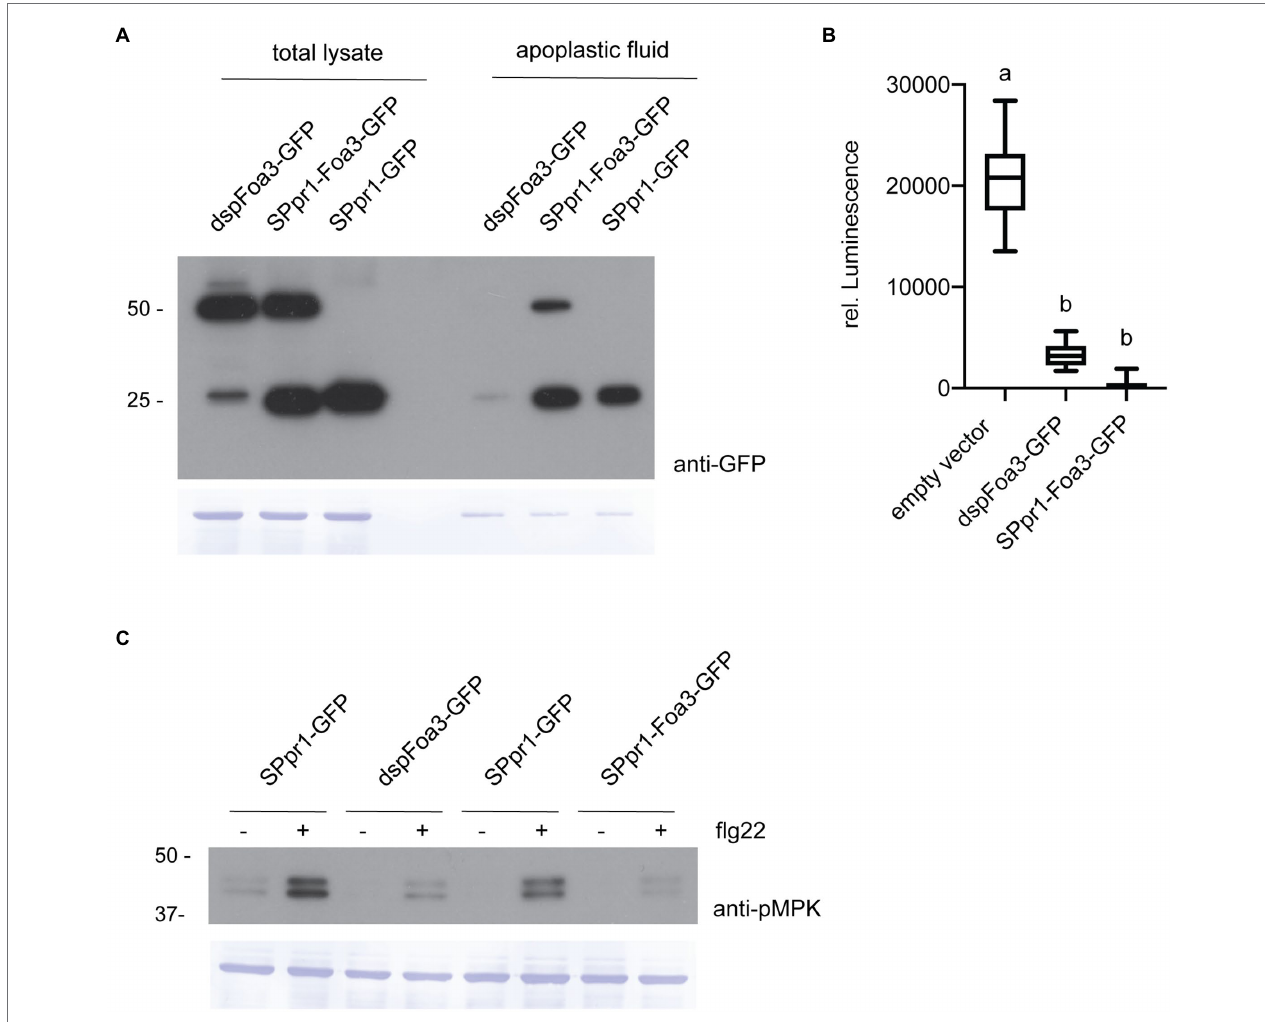
FIGURE 1 | Expression of Foa3 with or without the PR1 signal peptide sequence suppresses flg22-triggered defense responses. (A) Anti-GFP western blots showing accumulation of dspFoa3-GFP, SPpr1-Foa3-GFP and SPpr1-GFP in total protein lysates and in apoplastic fluid of Agrobacterium infiltrated Nicotiana benthamiana leaves. Molecular weight (kDa) markers are shown on the left. Equal loading is verified by Coomassie staining of the blots. (B) Flg22-triggered ROS burst in Nicotiana benthamiana plants expressing the indicated constructs. Boxes extend from the 25 th to the 75 th percentile, whiskers from the lowest to highest values, bar indicates the median, n = 12 leaf discs. Significant differences are indicated by the different letters ( p < 0.05, Kruskal-Wallace test). (C) Western blot showing flg22-triggered activation of MAP kinases in Nicotiana benthamiana leaves expressing the indicated constructs. Leaf discs were exposed to water ( − ) or flg22 (+) for 10 min. Molecular weight (kDa) markers are shown on the left. Equal loading is verified by Coomassie staining of the blots. Experiments were repeated three times with similar